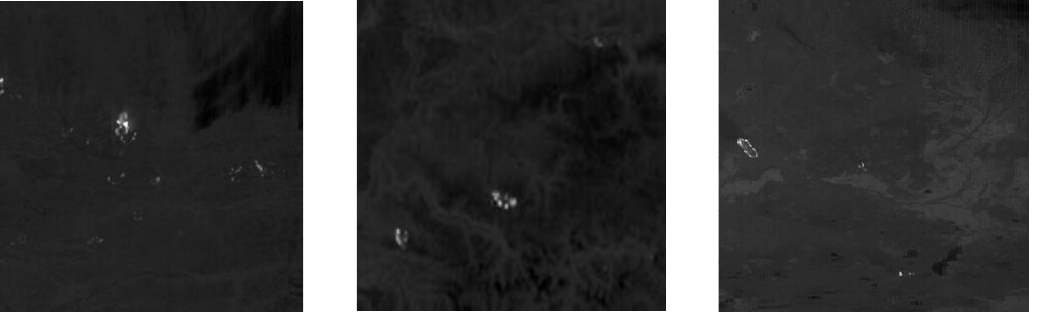
Figure 6. Grayscale of brightness temperature in channels; the bright white area represents the fire points, and the dark black area represents the unburned background area.